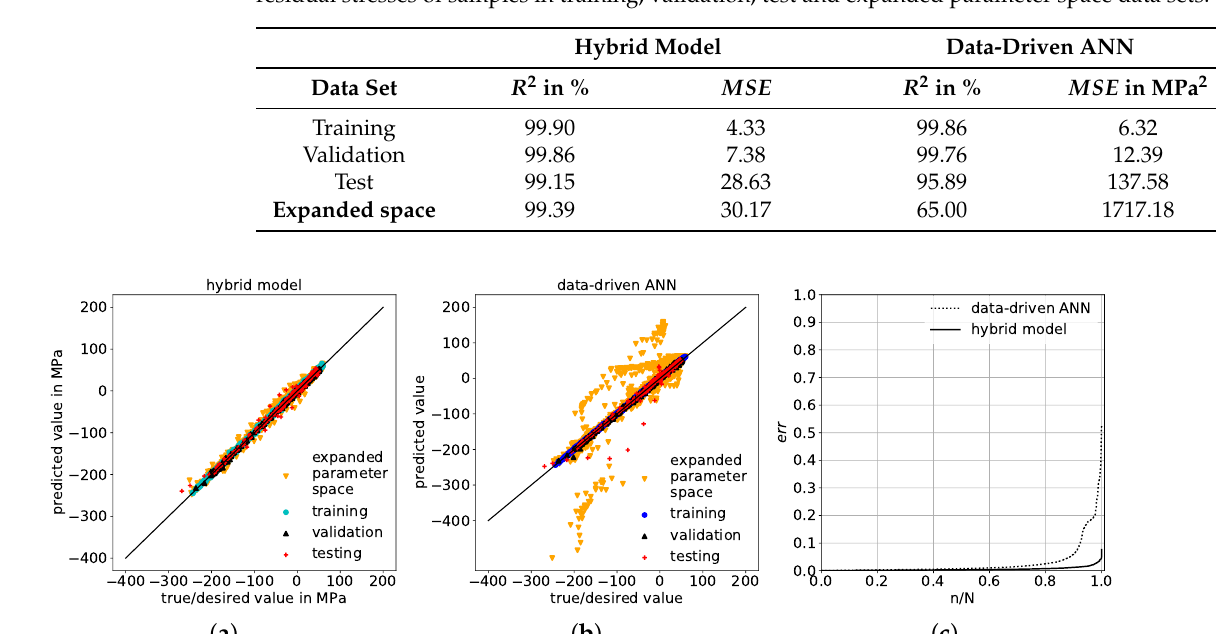
Table 6. Prediction metrics of the hybrid model and purely data-driven ANN: R 2 and MSE for residual stresses of samples in training, validation, test and expanded parameter space data sets.